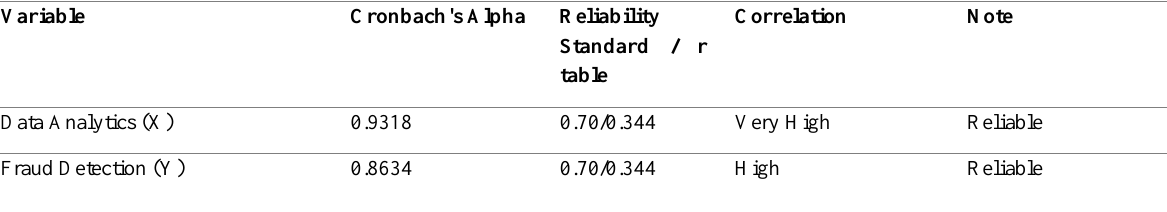
Table 4: Reliability Test